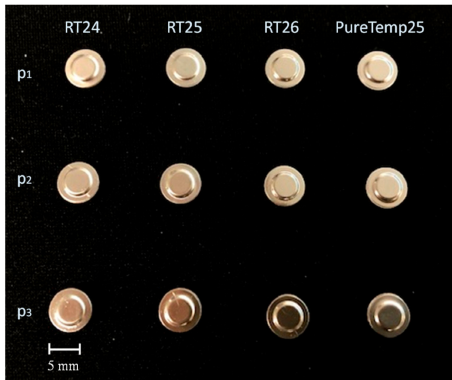
Figure 4. DSC specimens for the measurement of specific heat capacity and enthalpy of Phase Change Materials (PCMs) following the dynamic and stepwise procedures. Table 2. Samples, heating rates, investigated parameters and DSC test-type applied in this study.